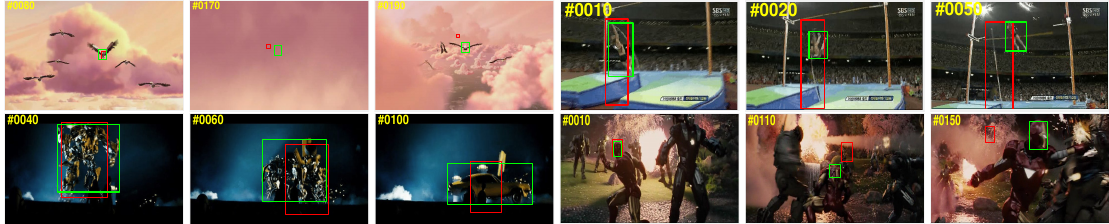
Figure 13. Failure cases of the proposed method on bird1, jump, trans, ironman [2], where we used red and green bounding boxes to denote our results and ground truths, respectively. Results are best viewed on high-resolution